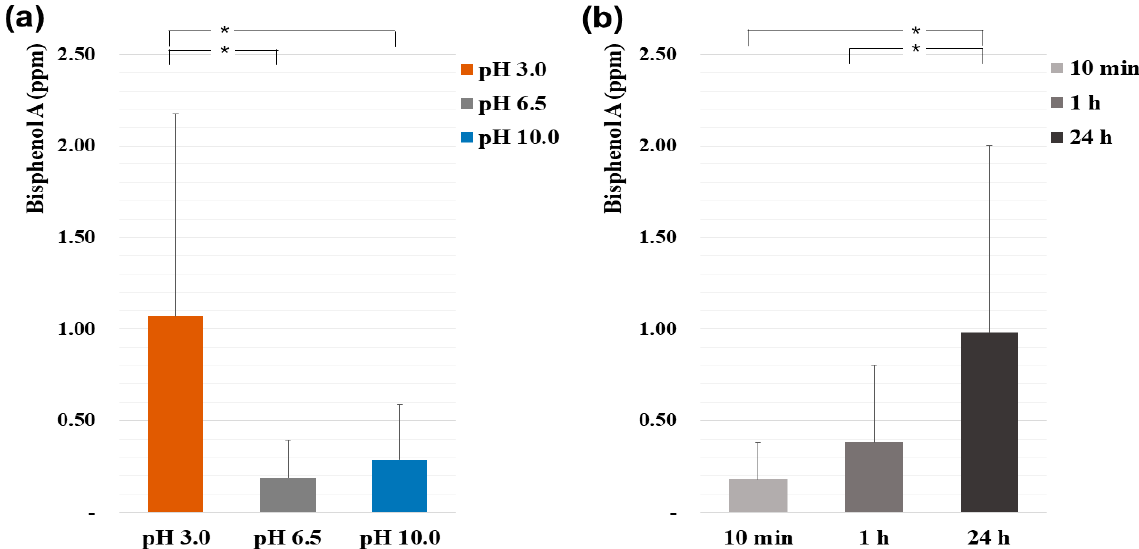
Figure 2. Differences in BPA concentration (ppm) according to each factor: ( a ) BPA release according to pH levels (* p < 0.05); ( b ) BPA release according to time (* p < 0.05).